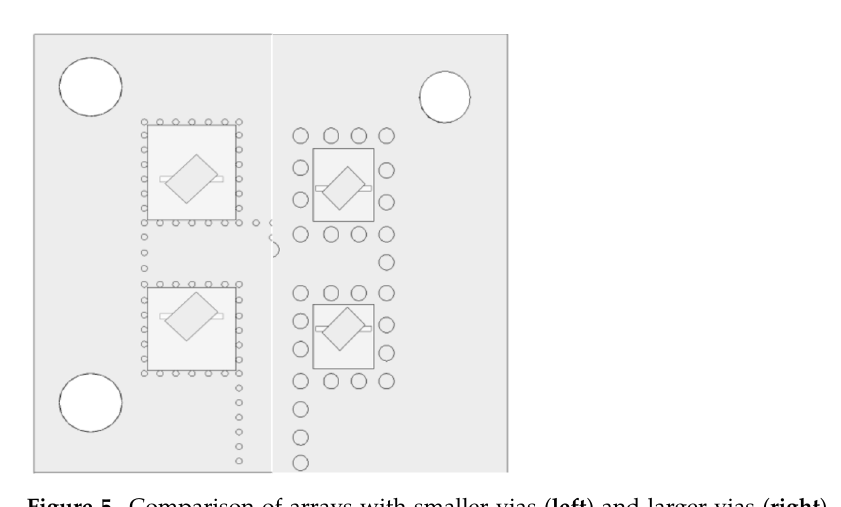
Figure 5. Comparison of arrays with smaller vias ( left ) and larger vias ( right ). Only half of the struc- tures are shown due to symmetricity.